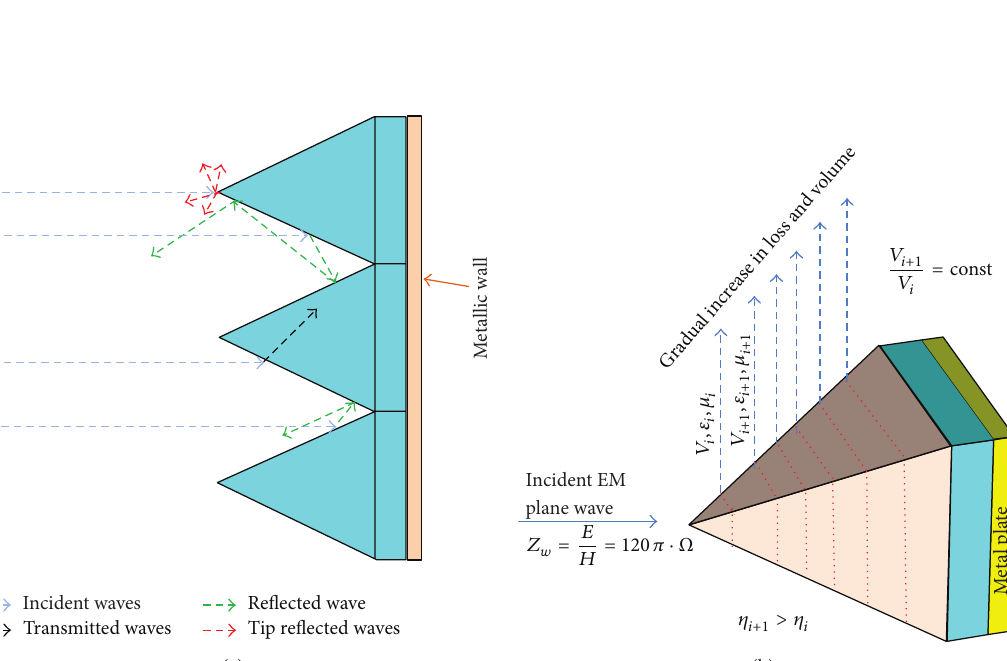
Figure 1: Illustration of wave-absorber interactions: (a) possible interactions of incident EMI signal with the wall of the anechoic chamber that is lined with a periodic array of pyramids; (b) sketch of a unit cell of the array of solid pyramids, showing a gradual increase in volume and loss factor along the axis of the wave